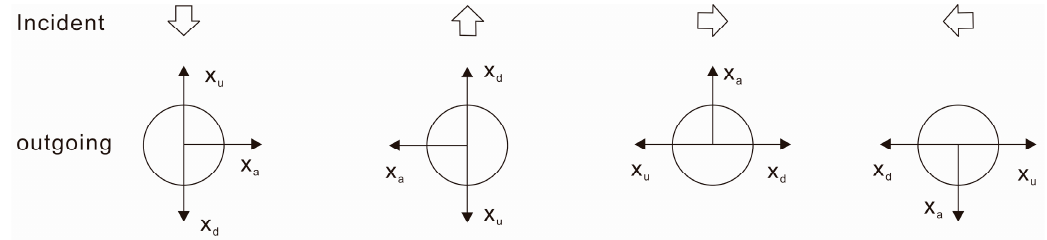
Figure 3. The directional changes of particle backscattering, lateral scattering and forward scattering ratios ( (cid:1876) (cid:3048) , (cid:1876) (cid:3028) and (cid:1876) (cid:3031) , respectively) with incident radiation. The arrows above indicate the directions of incident